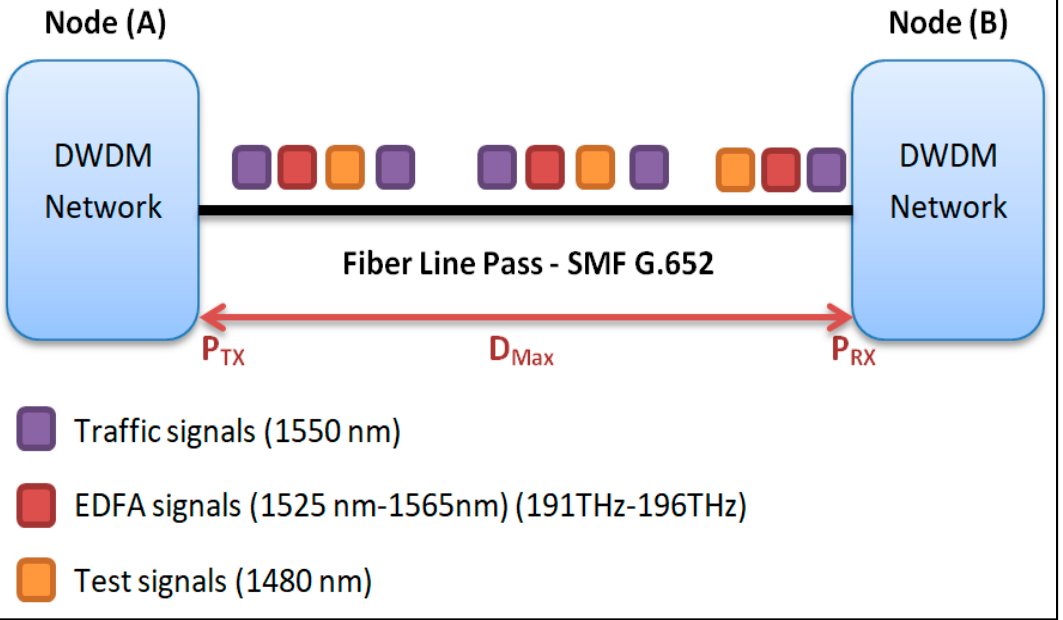
Figure 6. Maximum performance monitoring distance between two nodes by using an EDFA board.